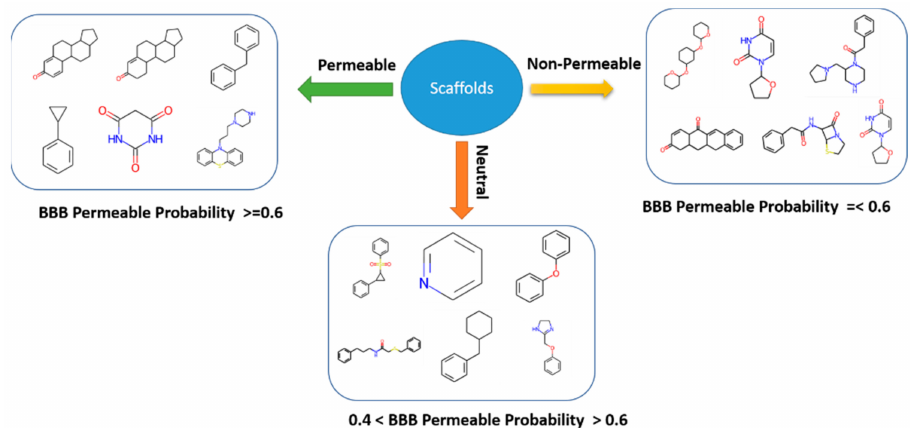
Figure 5. Grouping scaffold based on BBB permeability probability. Scaffolds with permeability prob- ability above 0.6 and below 0.6 are assigned as permeable and non-permeable scaffolds, respectively. Scaffolds between 0.4 and 0.6 are classified as